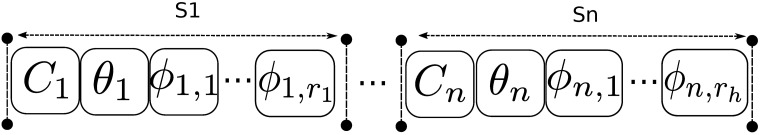
Solution representation.